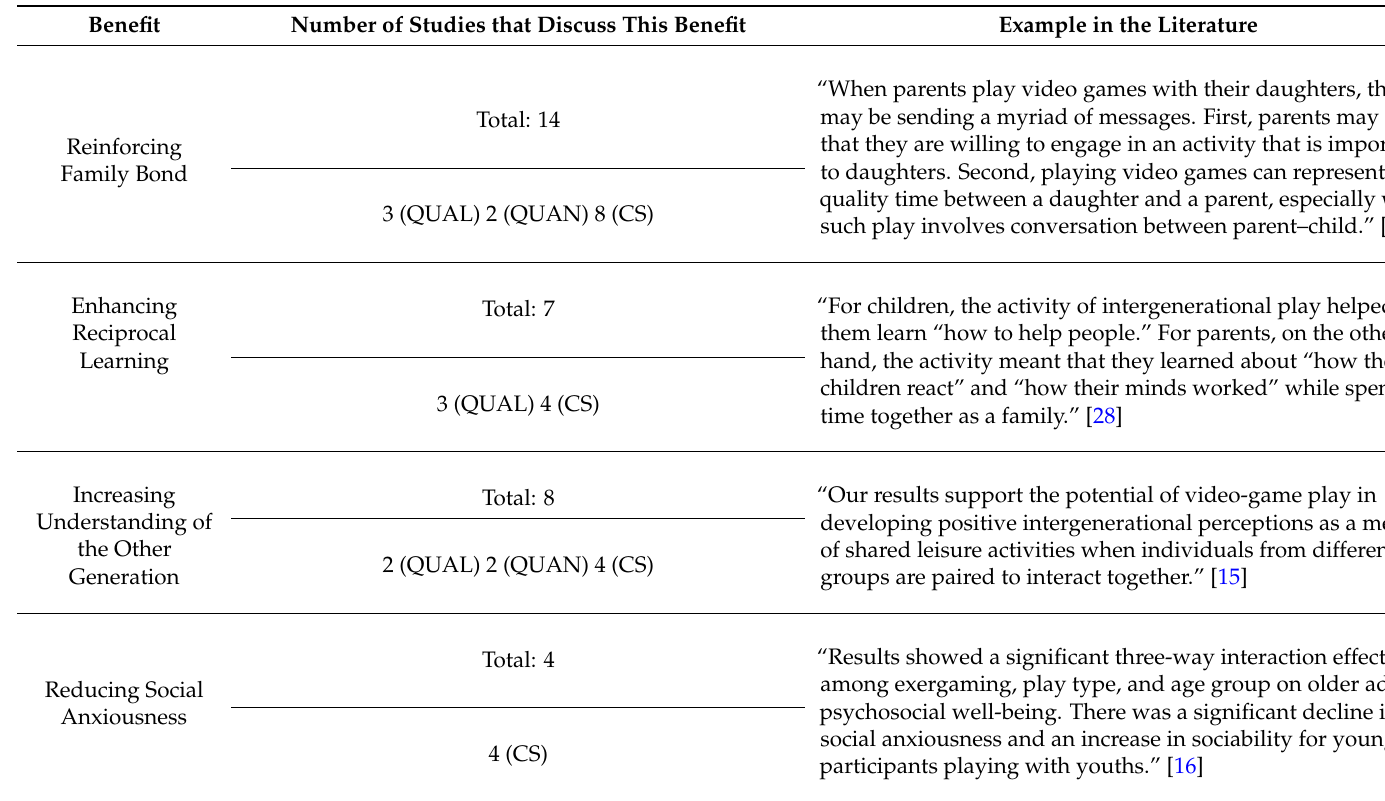
Table 2. The Benefits of Intergenerational Gaming Practices (QUAL: qualitative, QUAN: quantitative, CS: case